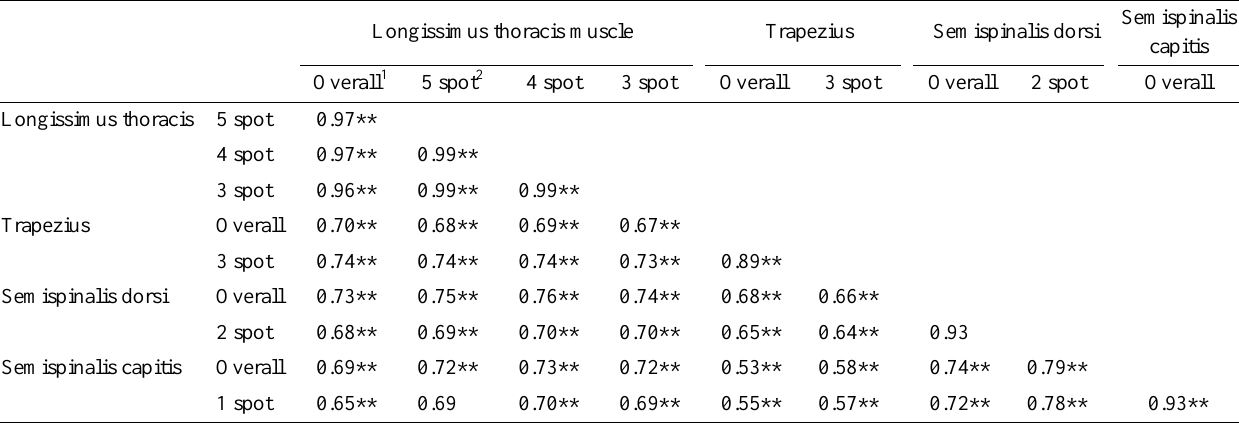
Table 3. Simple correlation coefficients of beef marbling (fat area ratio) between longissimus thoracis, trapezius, semispinalis dorsi and semispinalis capitis muscles by image analysis